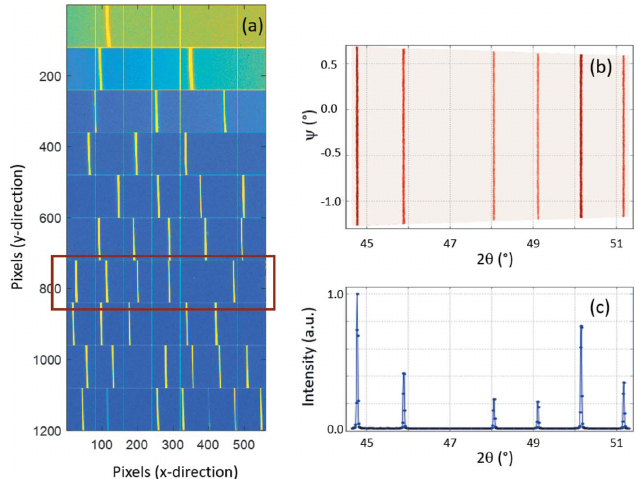
Figure 16 ( a ) Image of the data acquired with the CirPAD ( R z = 0 (cid:3) ), represented similar to Fig. 13. Only the first 10 modules are shown, with module 1 being located at the top of the image; ( b ) 2D regrouped image (intensity versus scattering angle 2 (cid:2) /azimuthal angle ) for the particular module (number 7) highlighted in part ( a ). In these coordinates, diffraction rings appear as straight vertical lines (2 (cid:2) = constant). The intensity colour scale is logarithmic. ( c ) The corresponding reconstructed 1D powder diffrac- tion pattern (logarithmic intensity